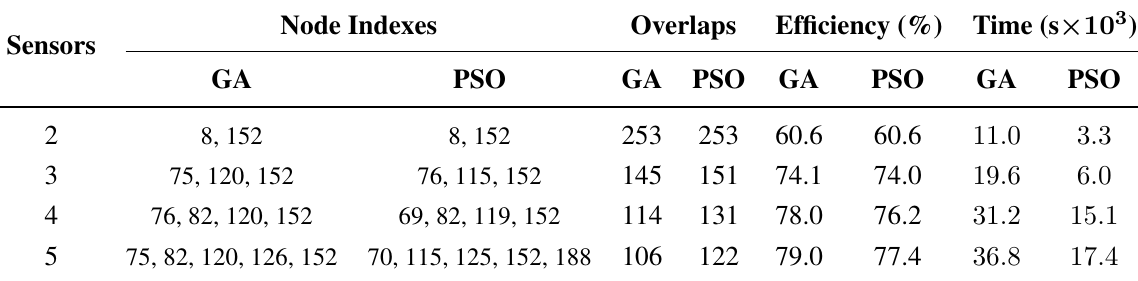
Table 5. Sensor placement in the Limassol WDN using stochastic approaches and a single time instant.